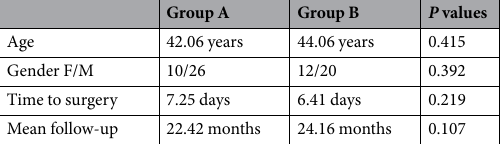
Table 3. Demographic data of two